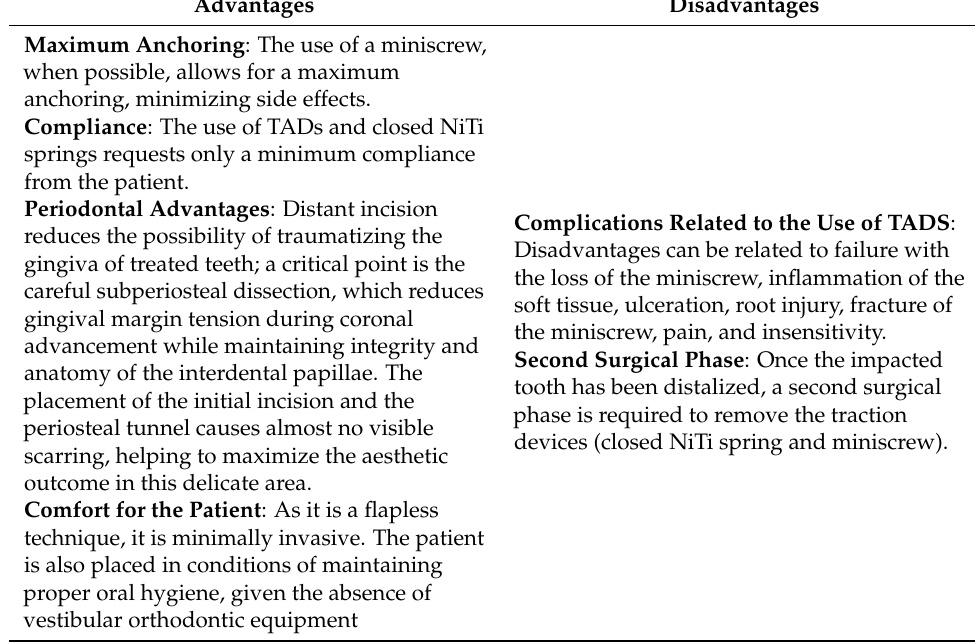
Table 1. Summary of advantages and disadvantages of the VISTA approach to canine disinclusion. Advantages